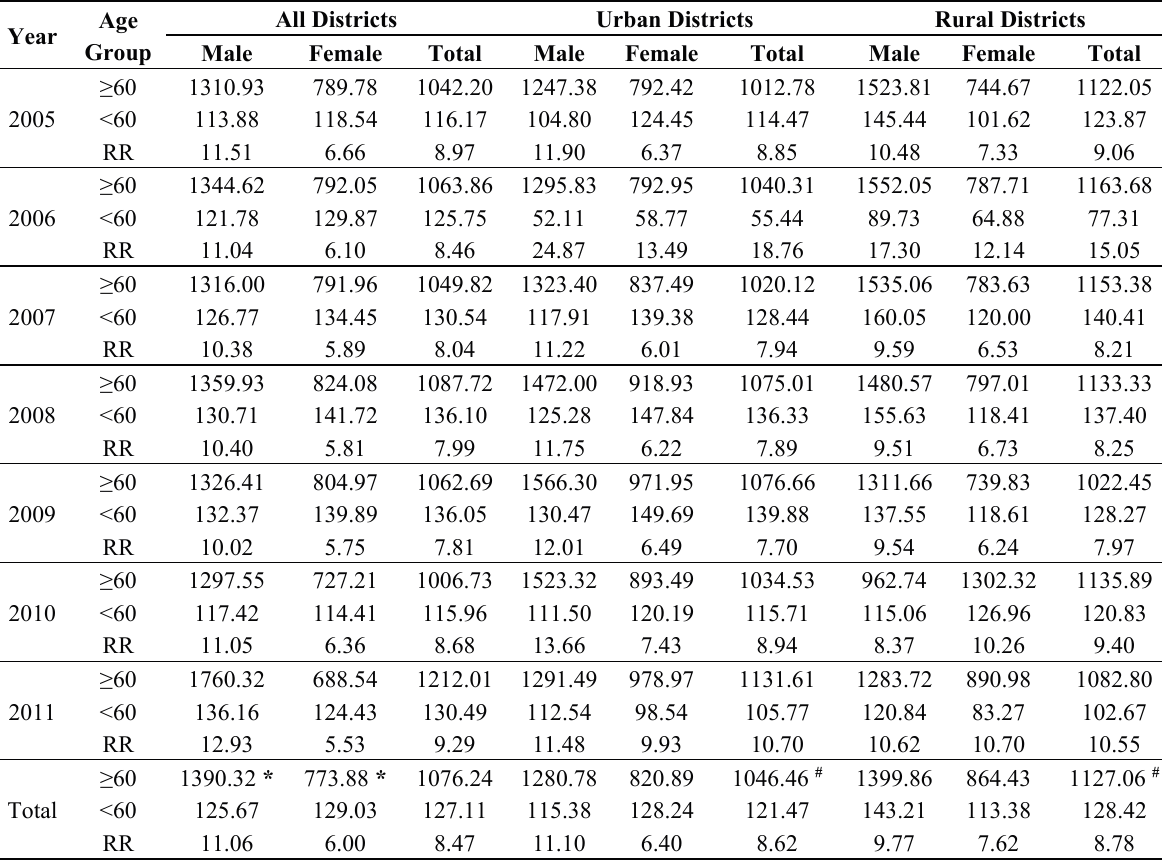
Table 1. Cancer incidences in the elderly and young populations in China, 2005–2011.